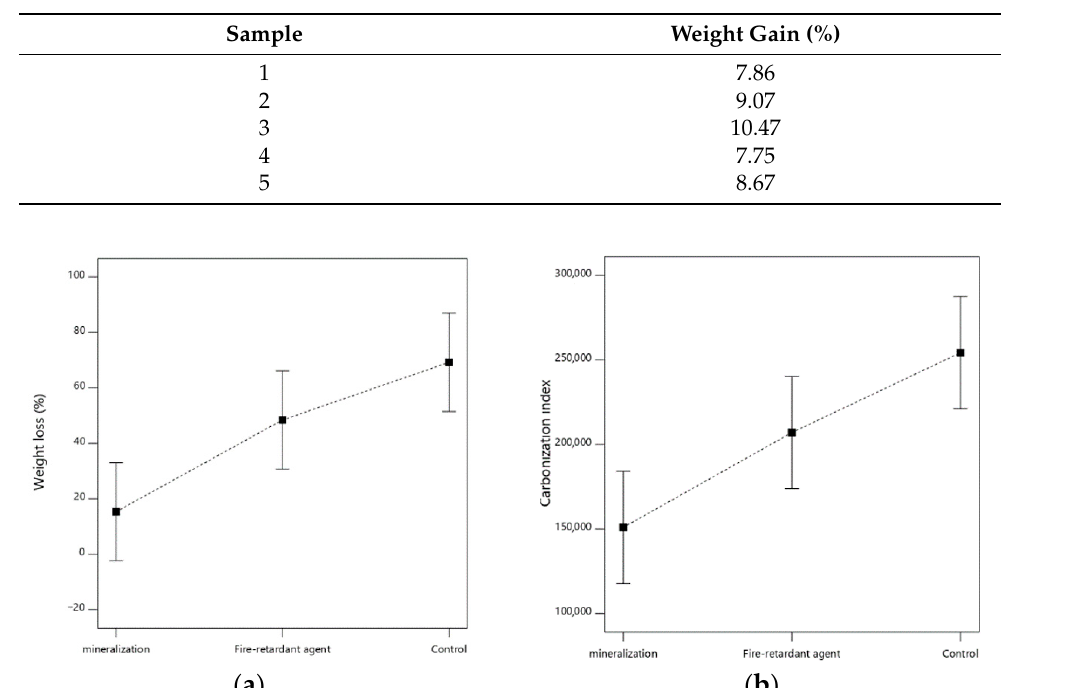
ples treated with the fire-retardant agent AF7000, and controls without treatment. Error bars depict the least significant difference (l.s.d.) after analysis of variance ( p < 0.05).